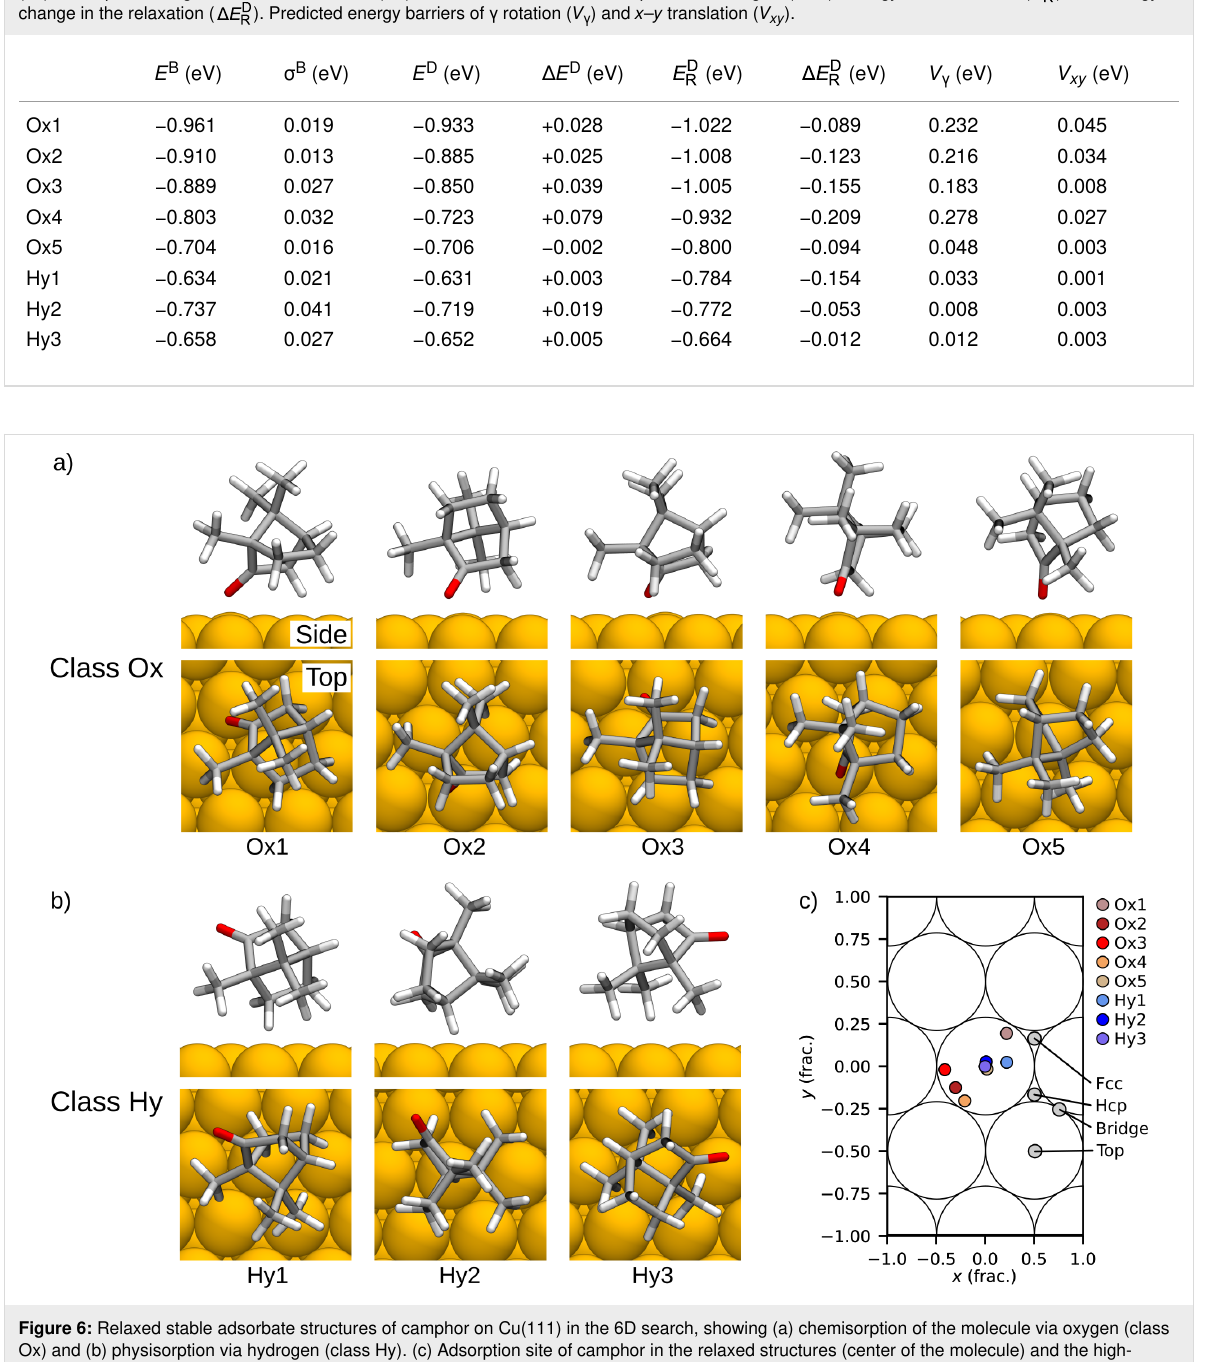
Table 1: Adsorption energies of the stable adsorbates, predicted by BOSS ( E B ), and their standard deviation in the surrogate model of the 6D PES ( σ B ). Adsorption energies calculated with DFT ( E D ) and their difference from the predicted energies ( Δ E D ). Energy after relaxation ( ), and energy change in the relaxation ( ). Predicted energy barriers of γ rotation ( V γ ) and x – y translation ( V xy ).